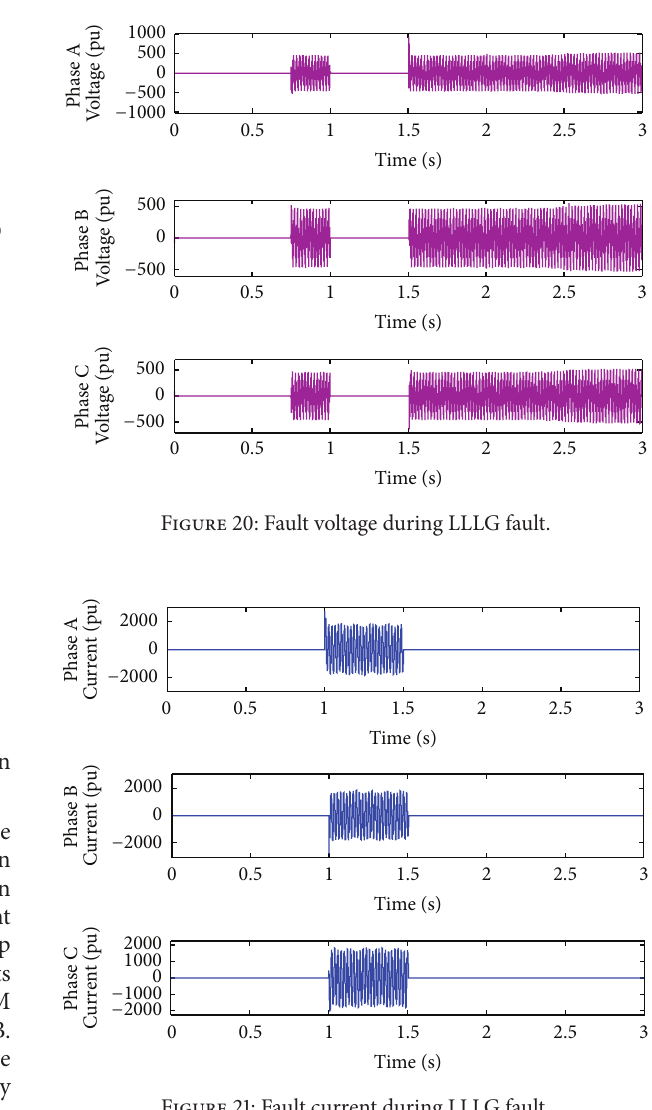
Figure 21: Fault current during LLLG